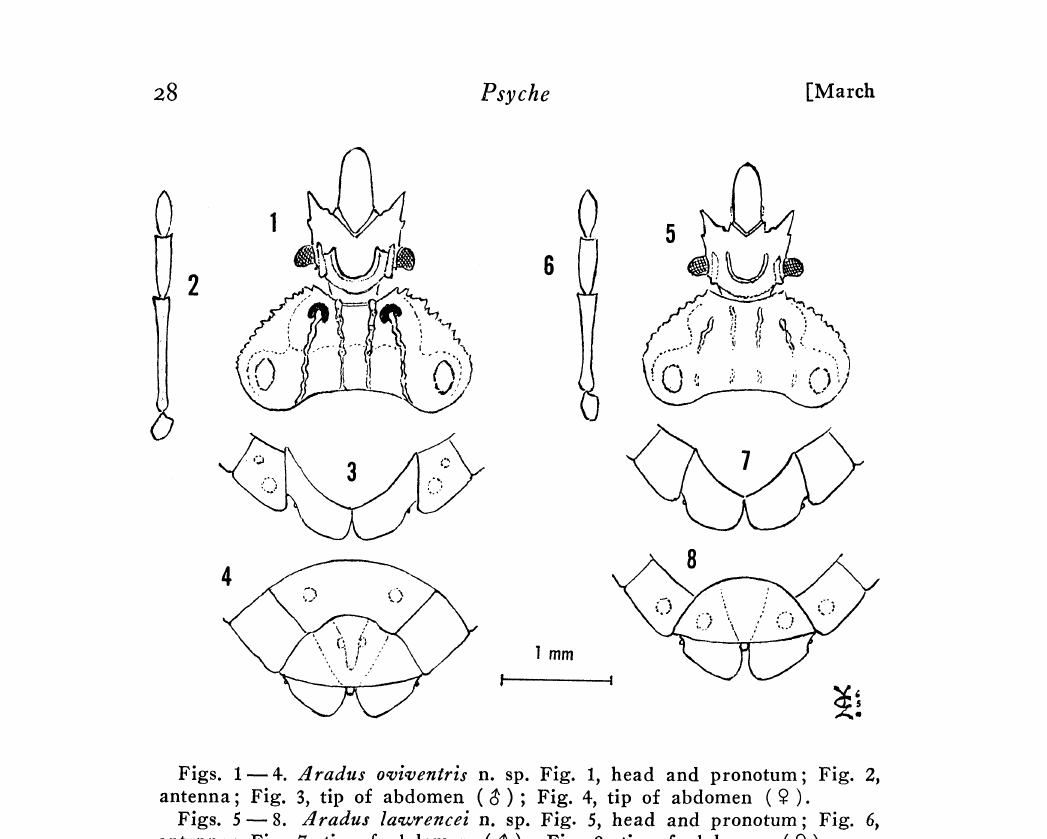
Figs. 1--4. dradus ovientris n. sp. Fig. 1, head and pronotum; Fig. 2, antenna; Fig. 3, tip of abdomen (); Fig. 4, tip of abdomen (). Figs. 5--8. dradus lawencei n. sp. Fig. 5, head and pronotum; Fig. 6, antenna; Fig. 7, tip of abdomen (); Fig. 8, tip of abdomen